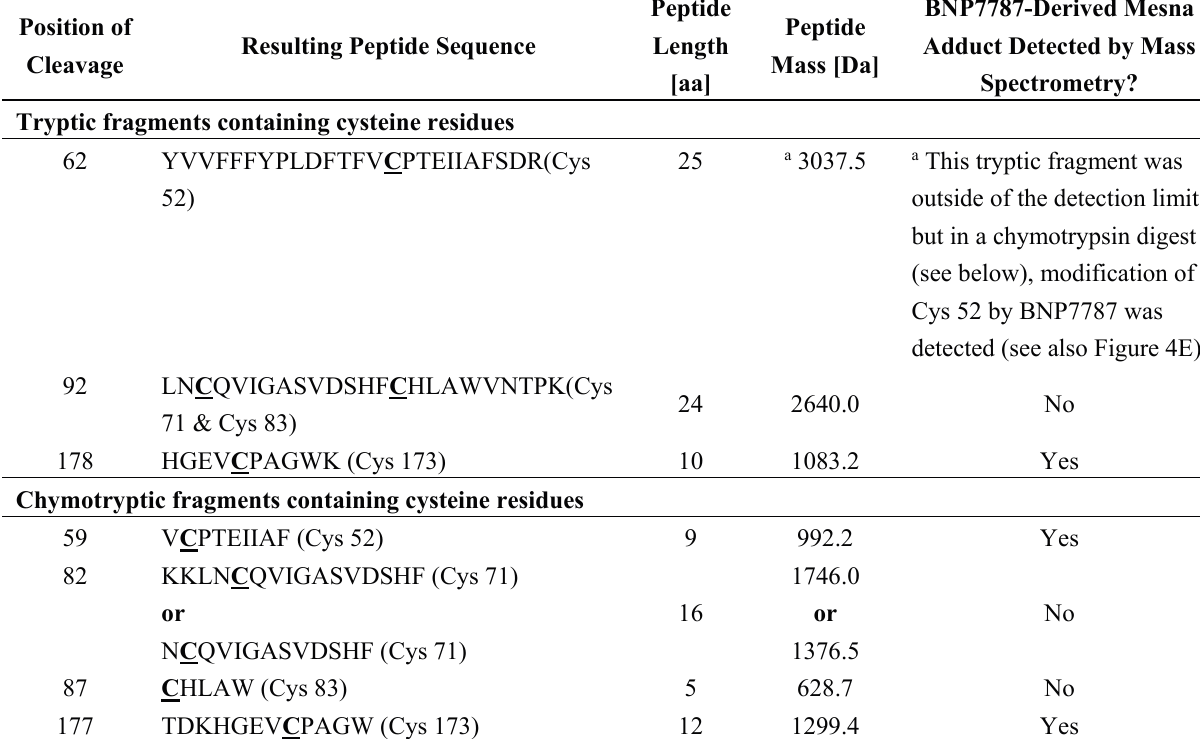
Table 2. Summary of tryptic and chymotryptic Prx 1 fragments containing cysteine residues analyzed by mass spectrometry for the presence of BNP7787-derived mesna adduct(s). (Note: the mass spectrometer utilized in these experiments was not calibrated to detect fragments larger than 2800 molecular mass. Therefore, experiments were done using both trypsin and chymotrypsin in order to generate digested fragments that contained all of the cysteine resides in peptides within the detection limit of the mass